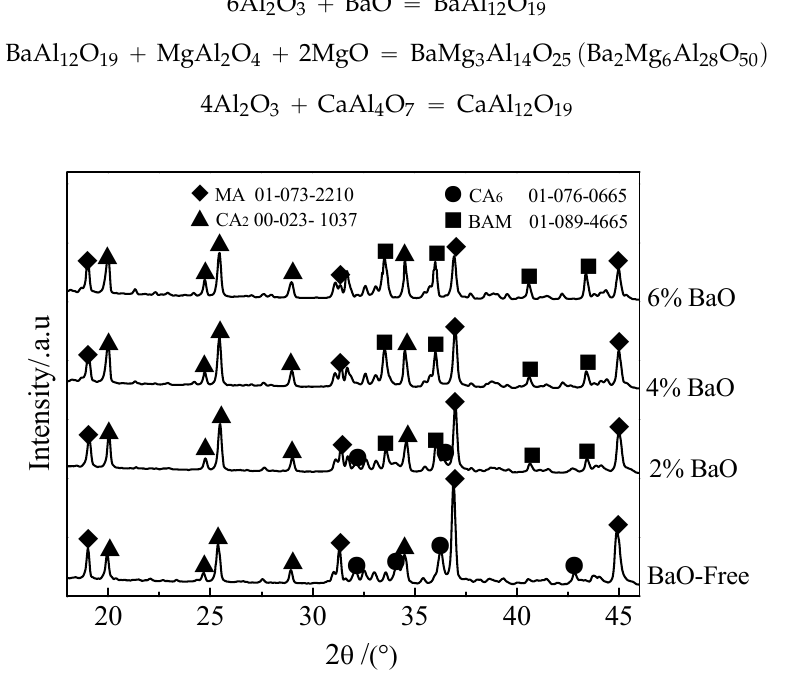
Figure 2. XRD patterns of the samples after heating at 1600 °C for 2 h in air.